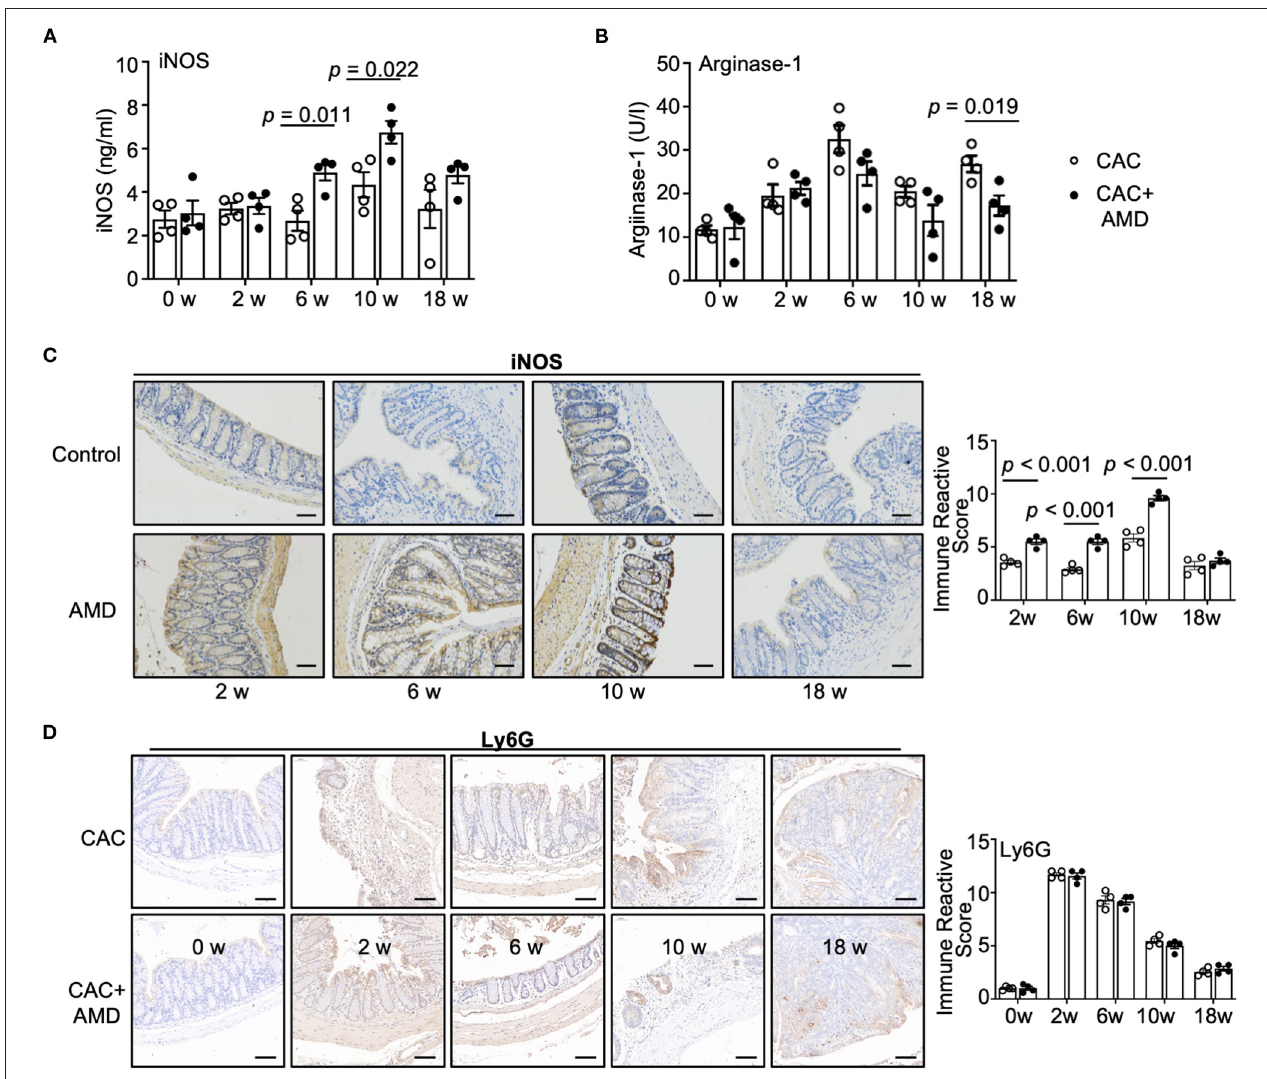
FIGURE 4 | AMD3100 regulated the levels of iNOS and arginase-1 in colonic tissues during CAC. (A) The expression of inducible nitric oxide synthase (iNOS) in colonic tissues was measured by ELISA ( n = 4). (B) The expression of arginase-1 expressions in colonic tissues was measured by ELISA ( n = 4). (C) The expression of iNOS was assessed by immunohistochemical staining and quantified by immune reactive scores (scale bar = 50nm, magnification 200 × ). (D) The expression of Ly6G was assessed by immunohistochemical staining and quantified by immune reactive scores (scale bar = 50nm, magnification 200 × ). Individual data are shown as Mean ± SD. Statistical analysis was carried out using unpaired t